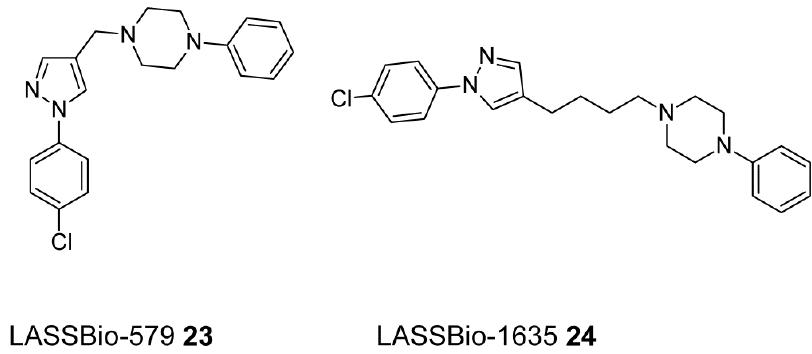
Figure 13. Potential multi-target (dopamine and serotonin receptor ligands) antipsychotics.